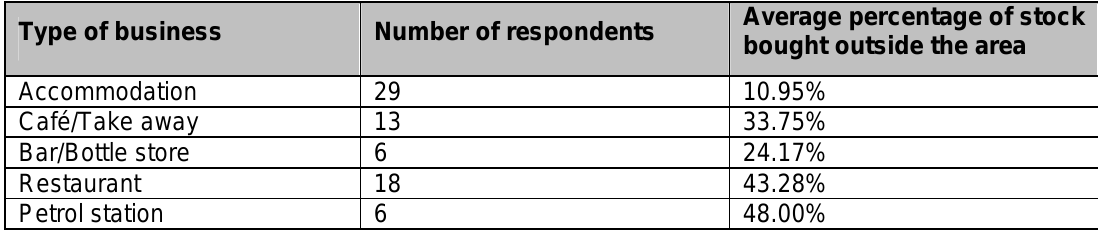
Average percentage of stock bought outside the